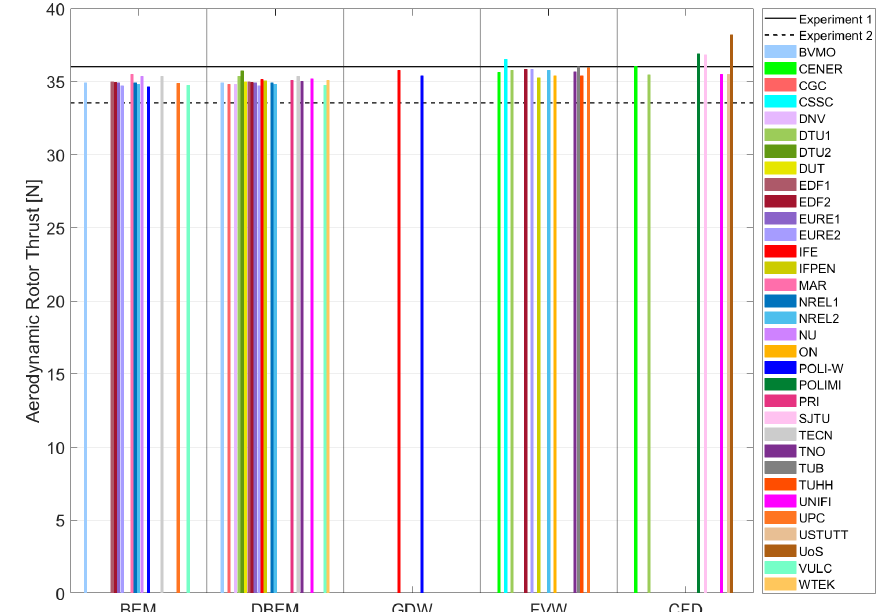
Figure 3. Aerodynamic rotor thrust in steady wind conditions (Load Case 1.1).